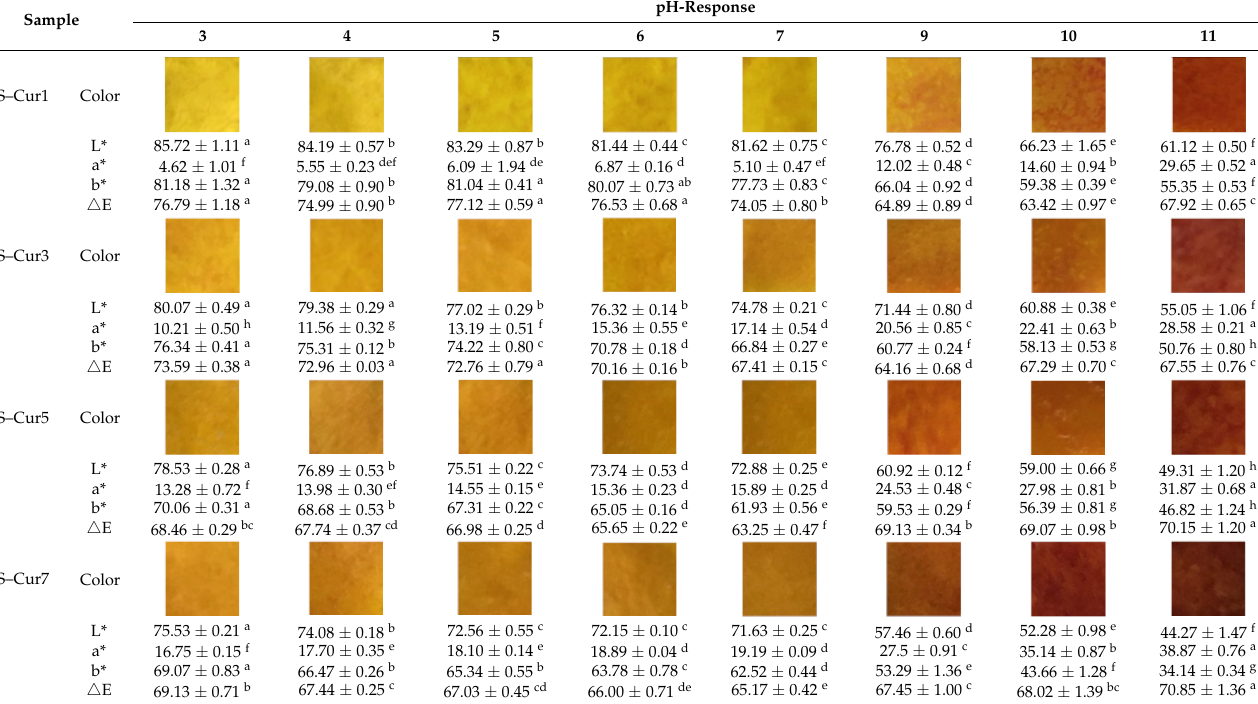
Table 5. Color response of zein/shellac films loaded with curcumin at different pH